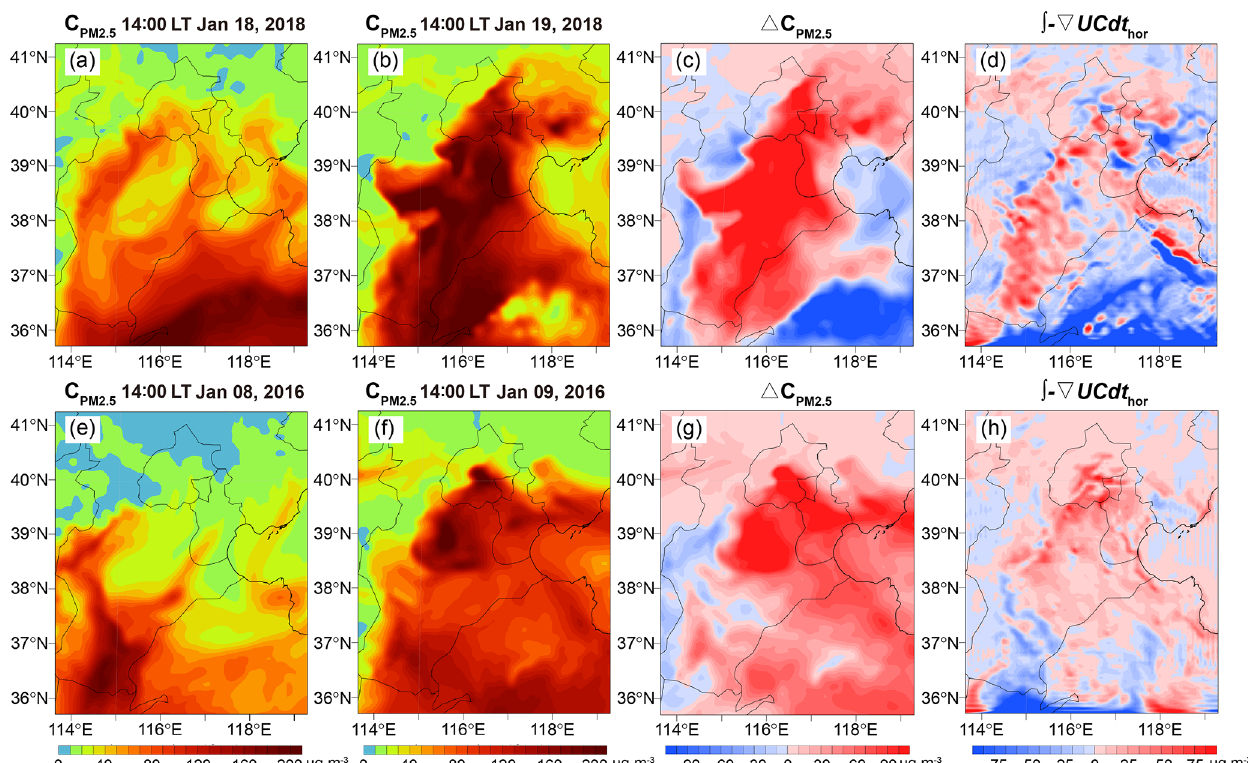
Figure 10. Simulated (a–b, e–f) near-surface PM 2 . 5 concentrations at two instants during the pollution formation–maintenance stage and (c, g) their difference, as well as (d, h) the temporal integration of the PM 2 . 5 horizontal advection term over this stage for case 1 (upper) and case 2